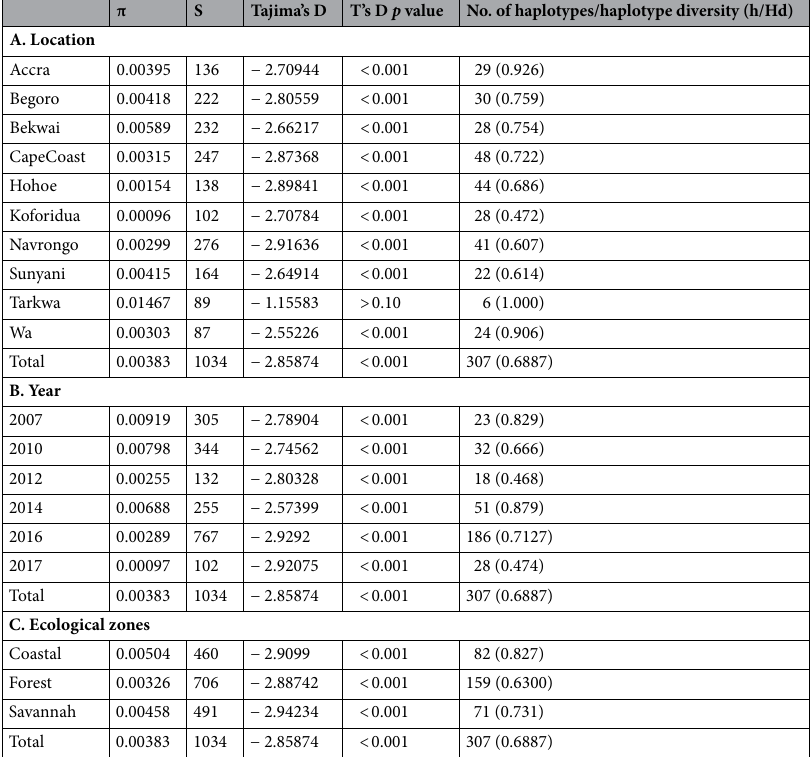
Table 2. Summary of computational analysis of DNA polymorphisms found in pfk13 in Ghanaian isolates by location, year and ecological zones. The computational analysis of the sequences to reveal the nucleotide diversity of the mutations in the pfk13 gene in Ghanaian isolates for study sites, year and ecological zones. S — number of segregating sites in the gene; π— nucleotide diversity at the gene locus.